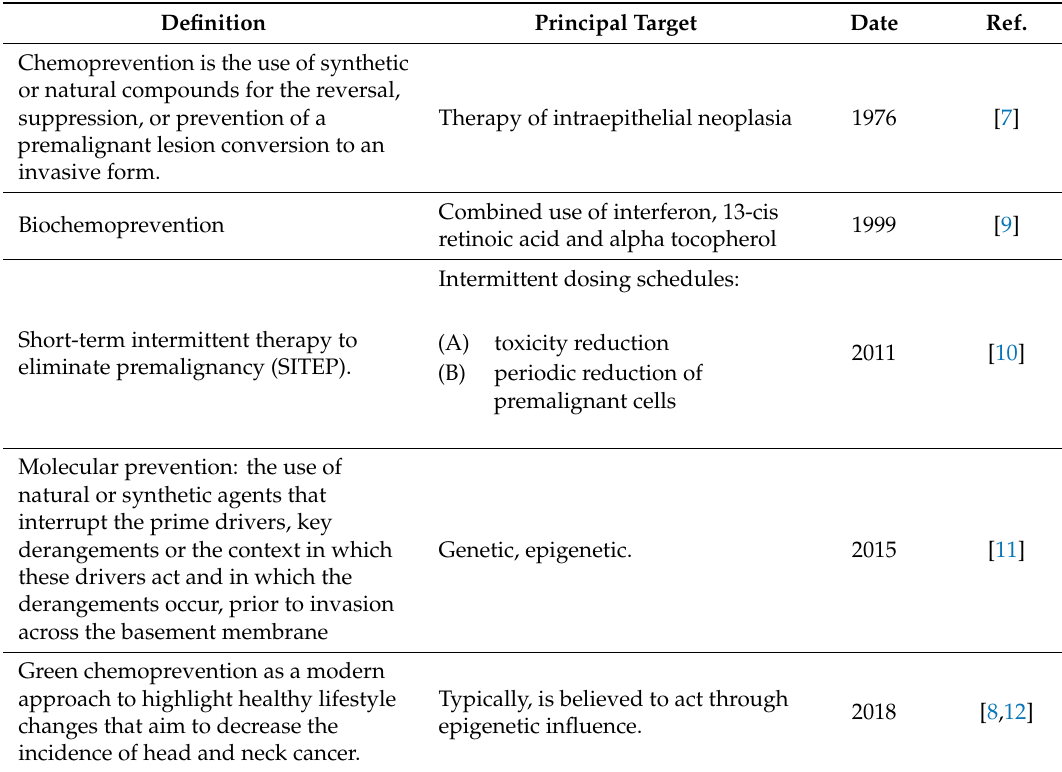
Table 1. Definitions of chemoprevention over time. Currently, there is no clinical evidence that pharmacological intervention can reduce cancer risk of malignant transformation of oral premalignant lesions. Taking in account the definitions, it is interesting to note that there has been a progressive translation from interventions based mainly on the theory of multiphasic carcinogenesis and with predominantly epithelial involvement to forms of treatment more aimed at the microenvironment as a whole. In this view, the hypothesis of modulation of immune response for prevention can be considered part of this process. Definition Principal Target Date